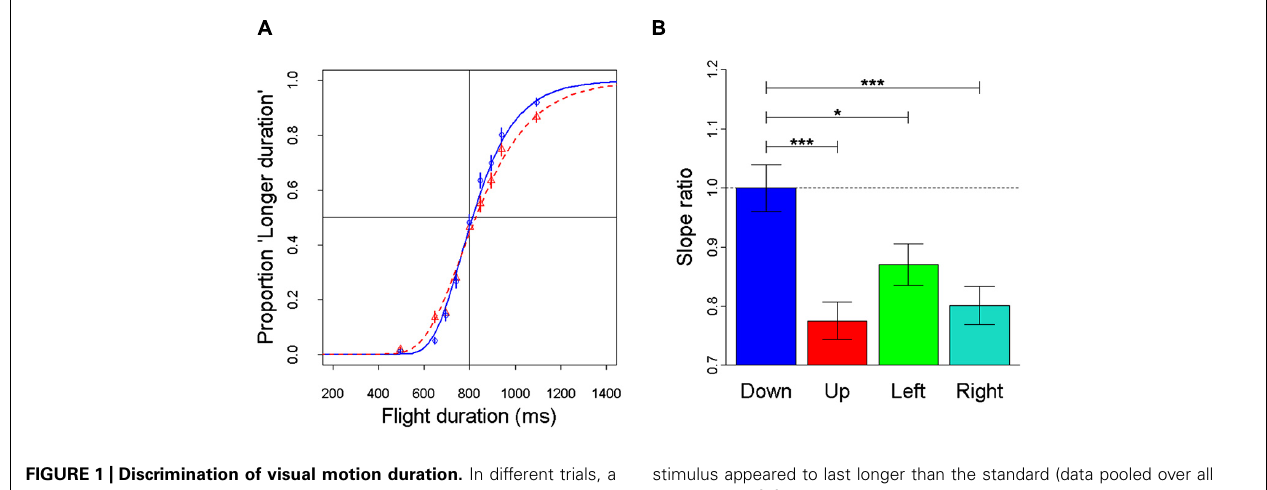
stimulus appeared to last longer than the standard (data pooled over all participants). (B) For each motion direction, the precision of discrimination was assessed as the slope of the population response (all values normalized relative to the downward condition): the higher the slope, the greater the precision. Error bars: ± 1 SD. Significant differences: *** p < 0.001 and * p < 0.05. Replotted with permission from Moscatelli and Lacquaniti